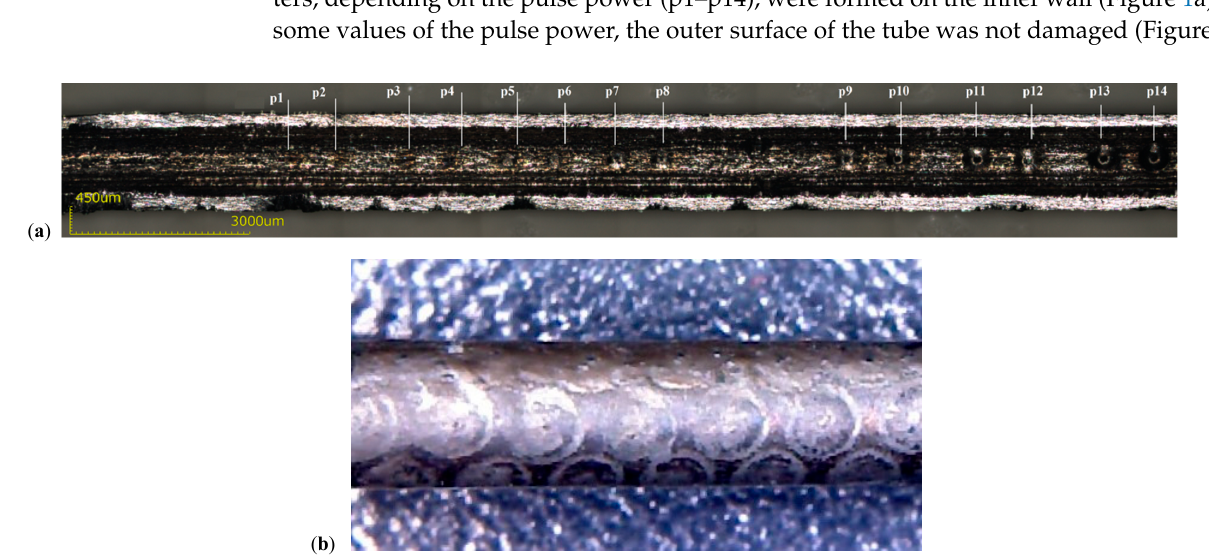
( b ) External surface after exposure with the technological current value I = 130 A.